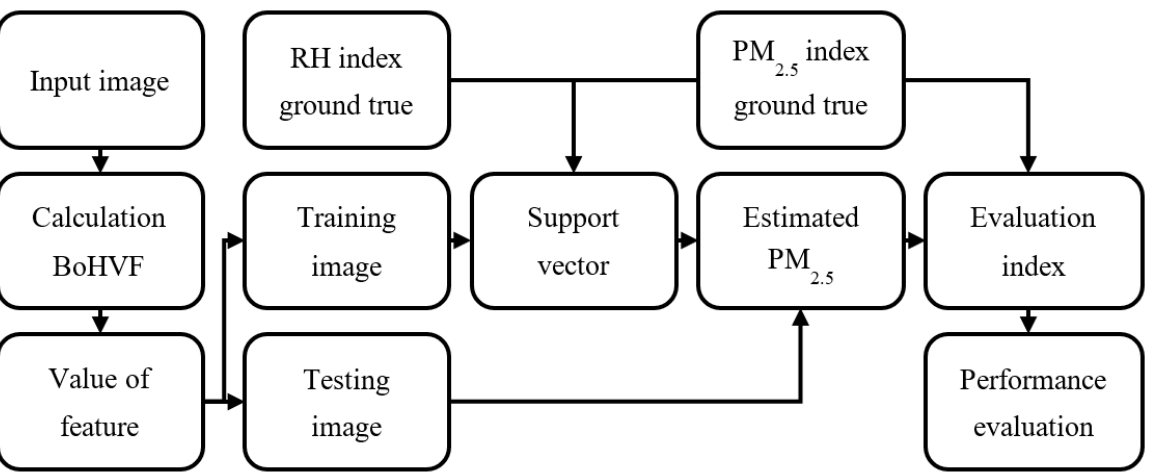
Figure 3. A flow chart of the method of estimating AQI.